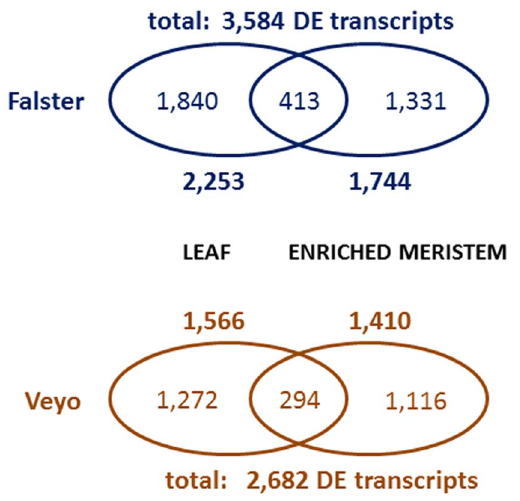
Figure 2. The number of differentially expressed transcripts common and specific for each sample type.